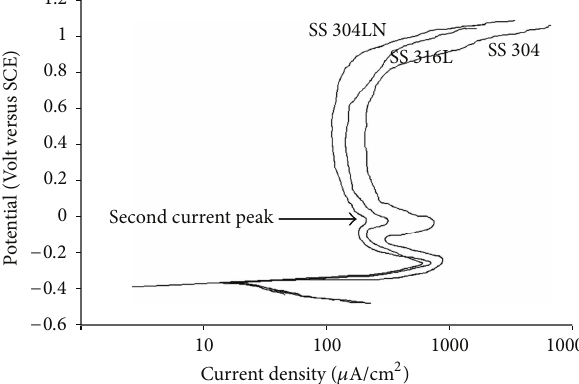
Figure 8: Anodic polarization curve for types 304, 316L, and 304LN austenitic stainless steels in a solution of 0.5 M sulfuric acid (